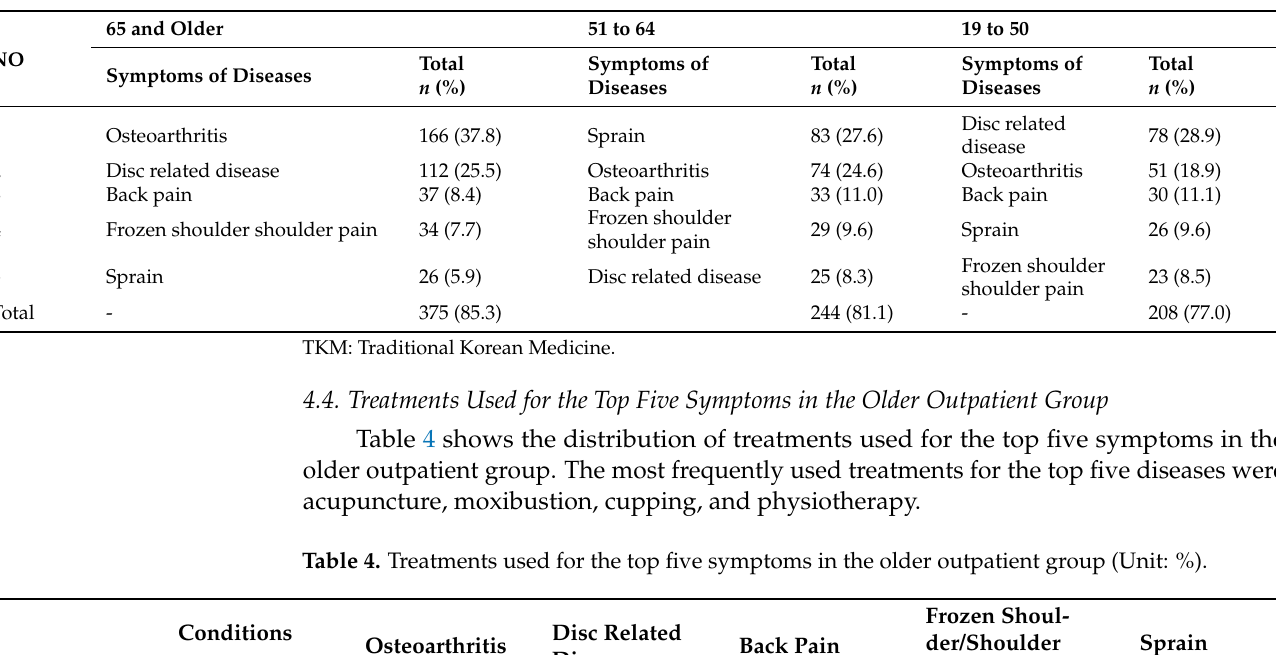
Table 3. Top five symptoms and diseases of outpatients using TKM.